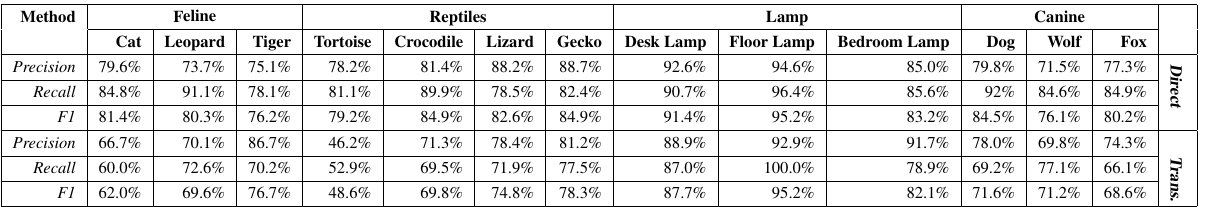
Table 3: Experimental results for with seeds (top) and with only transfer (bottom).